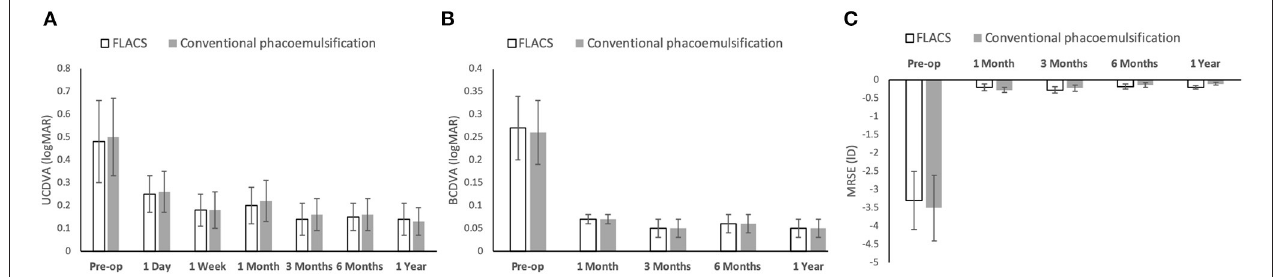
FIGURE 1 | Bar graph showing the visual and refractive outcomes following FLACS and conventional phacoemulsification over the study period of 1 year. There was no significant difference in the UCDVA (A) , BCDVA (B) , and MRSE (C) between the two groups at all the post-operative time points. Error bars indicate standard deviation.